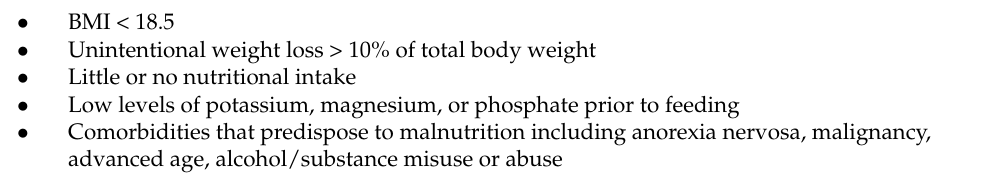
Table 5. Risk factors for refeeding